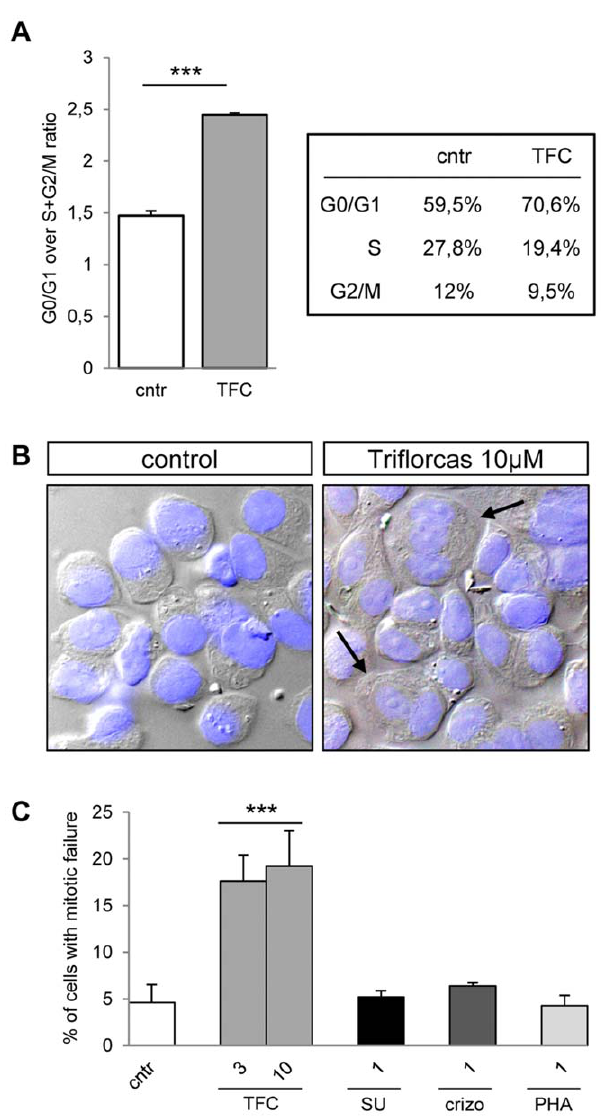
Figure 7. Triflorcas perturbs cell cycle progression, leading to mitotic failure. (A) Graph showing the ratio of percentage of GTL-16 cells in G0/G1 phase over the percentage of cells in S + G2/M phase. Cells were treated with Triflorcas (TFC; 3 m M), or vehicle (cntr) for 48 hours, then stained with propidium iodide. Values are expressed as means 6 s.e.m. ***P , 0.001; Student- t test (n=3). Percentages of cells in G0/G1, S, and G2/M phases are reported in the table. (B) GTL-16 cells were grown in the presence of Triflorcas or vehicle and nuclei were visualized using DAPI staining. Arrows show example of cells with multiple nuclei (40X magnification). (C) Quantification of cells with mitotic failure expressed as percentage of the total number of cells analyzed. Triflorcas (TFC; 3 or 10 m M), but not SU11274 (SU; 1 m M), crizotinib (crizo; 1 m M), or PHA665752 (PHA; 1 m M) led to a significant increase in the number of cells with mitotic failure. Values are expressed as means 6 s.e.m. ***P , 0.001; Student- t test.